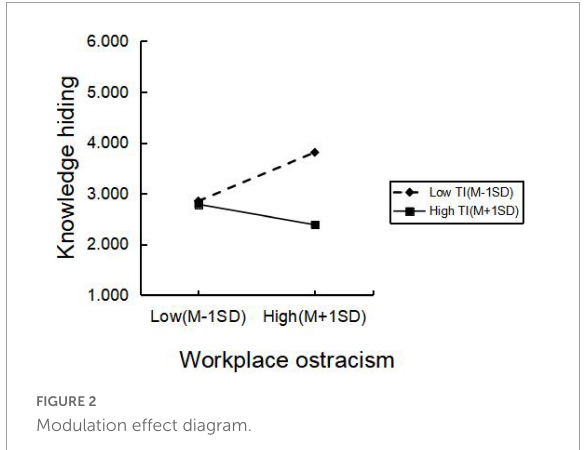
FIGURE2 Modulation effect